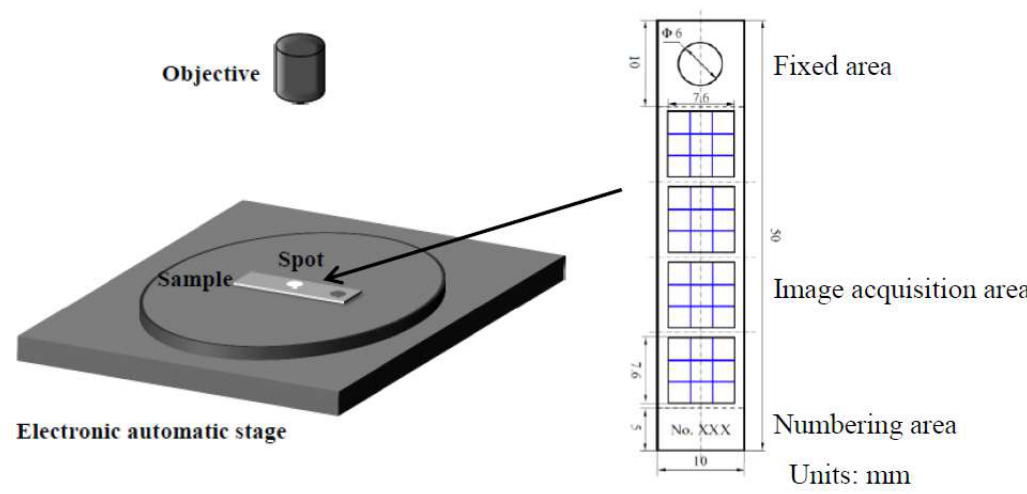
Figure 2. Schematic of image acquisition.